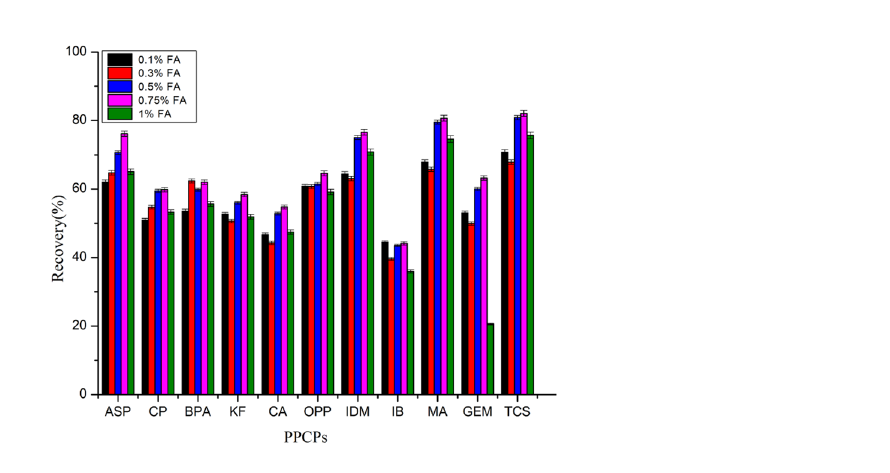
Figure 5. Recovery for the extraction of 11 target compounds (CP, ASP, CA, BPA, KF, OPP, IDM, IB, MA, and TCS) using a mixture of FA and ACN at different